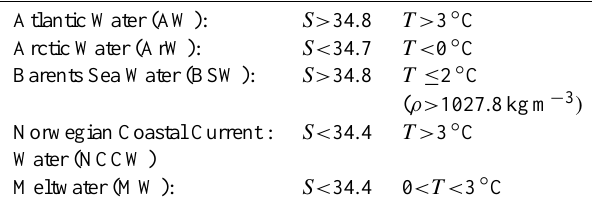
Table 1. Water mass definitions for the Barents